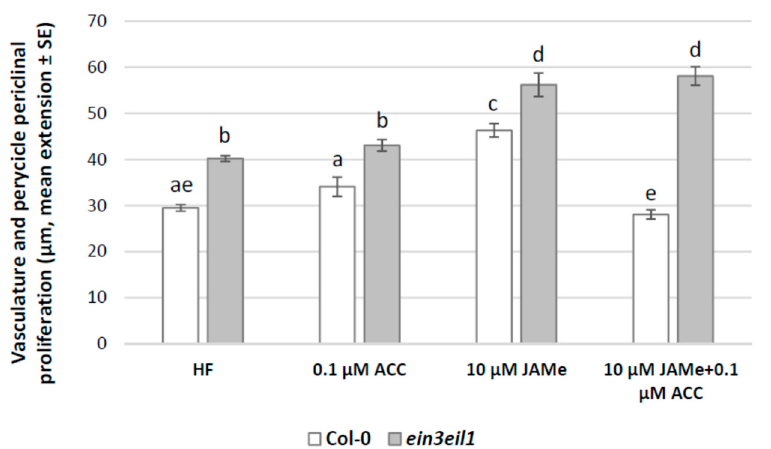
Figure 3. Pericycle periclinal proliferation in the basal hypocotyl of Arabidopsis Col-0 (wt) and ein3eil1 double mutant seedlings either cultured with ACC (0.1 μ M), or with JAMe (10 μ M) alone or combined with ACC (0.1 μ M), and without exogenous hormones (hormone-free, HF). Mean radial extension (± Standard Error (SE)) of the vasculature plus pericycle periclinal proliferation in the basal 5 mm of the hypocotyl. Different letters among different treatments within the same genotype, or between the two genotypes within the same treatment, indicate significant differences at least at p < 0.05. The same letters indicate no significant difference. Two-way ANOVA followed by Tukey’s post-test. n = 30.